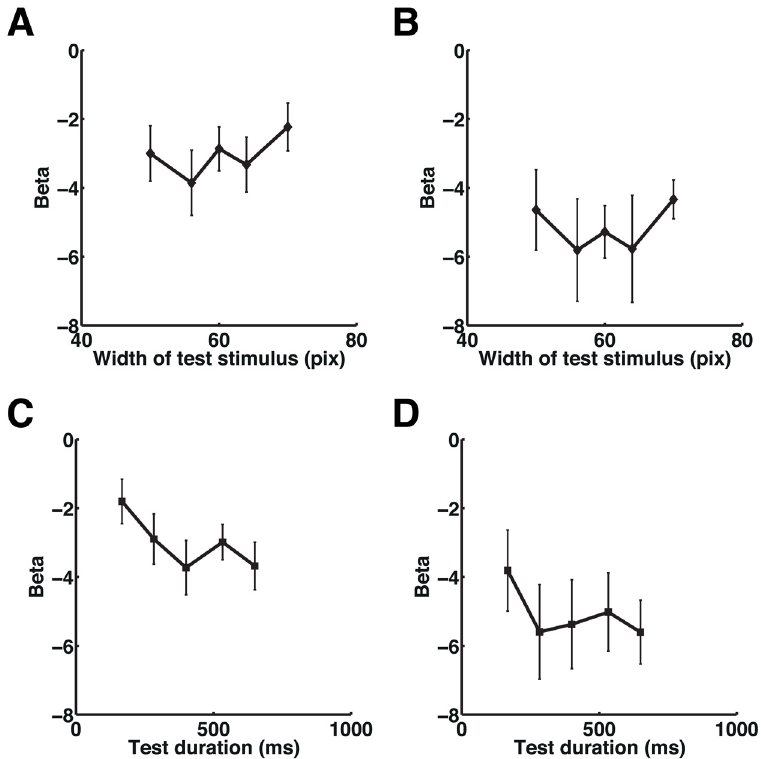
Fig 5. Plots of the beta values in the SMG. Plots of the relationship between beta values and the test stimulus width in experiment 3 are shown at the peak coordinates in the right SMG ( x , y , z = 58, − 42, 30) that showed a duration adaptation effect in experiment 1 (A) and in the right SMG ( x , y , z = 62, − 34, 32) that showed a duration adaptation effect in experiment 2 (see Fig 2) (B). Plots of the beta values for each set of test durations at the same coordinates as in Fig 5A and 5B are shown in (C) and (D), respectively. Please note that, while the beta values in (C) showed significant duration adaptation effect, the beta values in (D) ( x , y , z = 62, − 34, 32) did not reach statistical significance. Error bars indicate standard errors of the mean. Please refer to S1 Data for the numerical values underlying these figures.